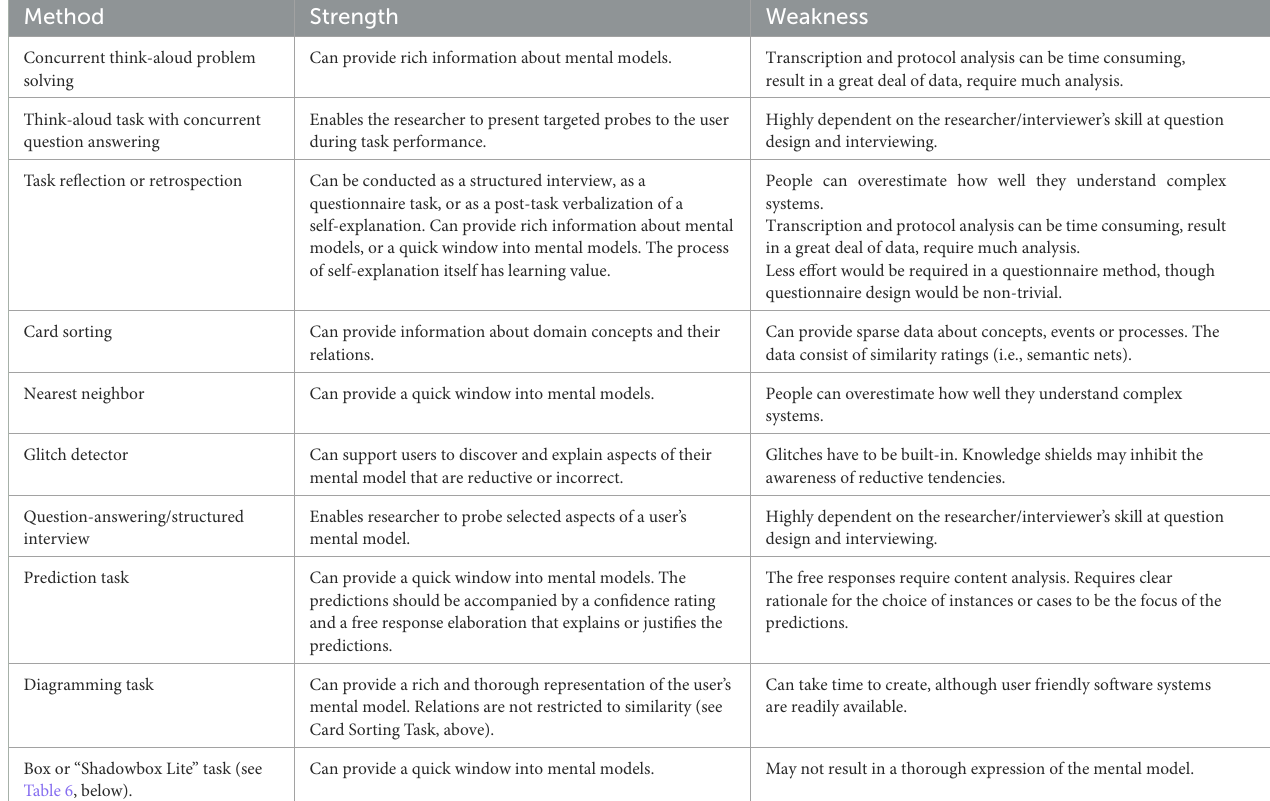
TABLE 5 Methods strengths and weaknesses. Method Strength